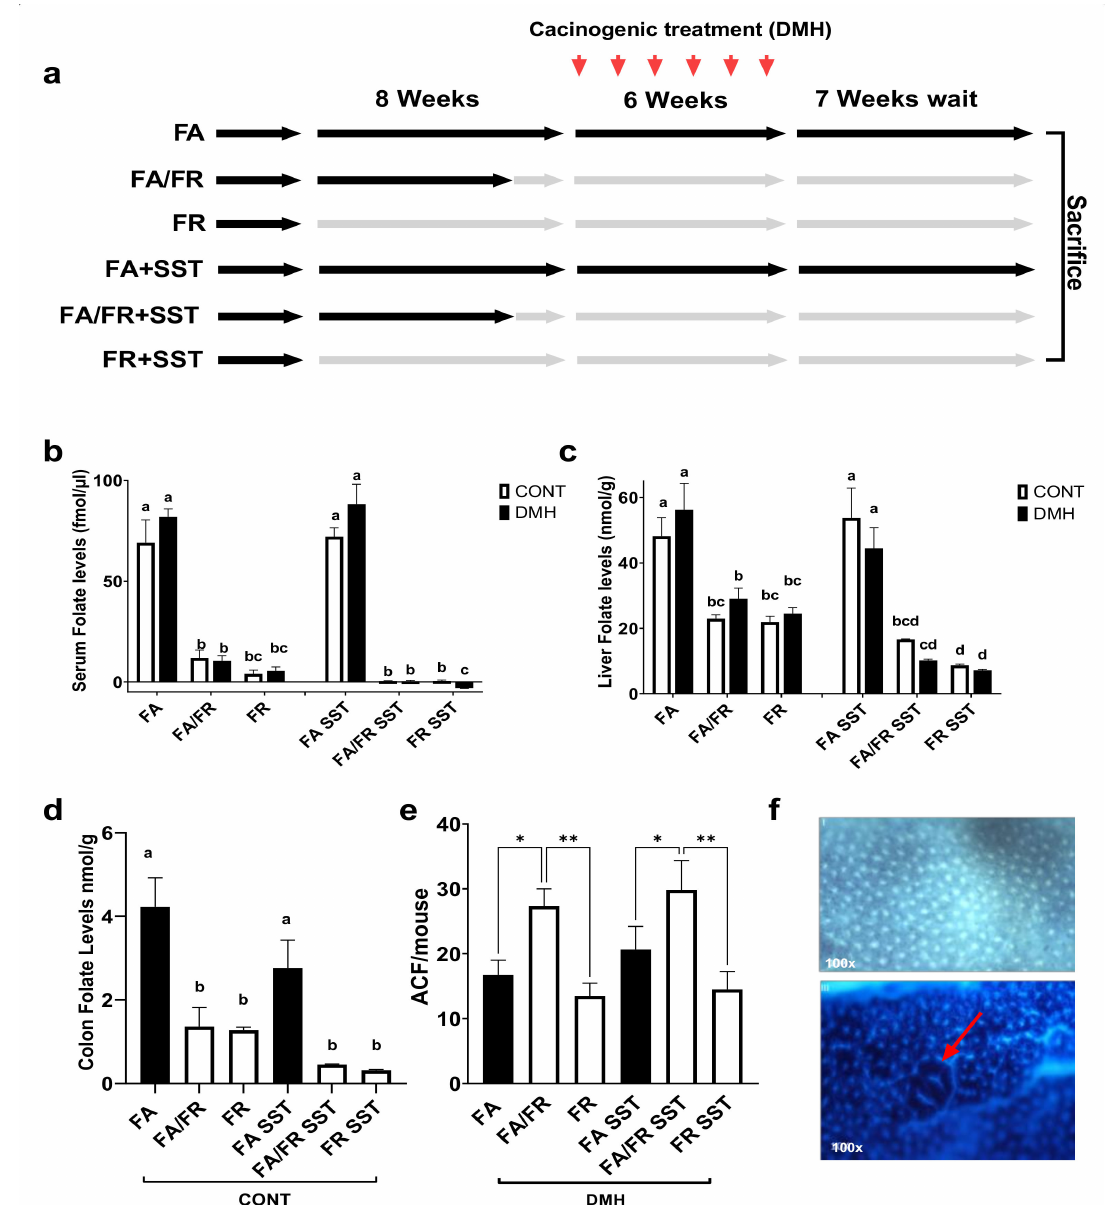
Figure 1. FR reduces ACF formation in DMH-treated male C57BL/6 mice compared to FA/FR, irrespective of SST treatment. ( a ) Study design. ( b ) Effect of FA/FR +/ − SST and FR +/ − SST on serum folate levels. ( c ) Effect of FA/FR +/ − SST and FR +/ − SST on liver folate levels. ( d ) Effect of FA/FR +/ − SST and FR +/ − SST on colon folate levels in untreated controls. ( e ) Effect of FA/FR +/ − SST and FR +/ − SST on colon ACF formation in DMH-treated mice. ( f ) Top image is a stained colon displaying normal crypts, bottom image shows a raised ACF in the center (red arrow). FA = folate adequate diet, FA/FR = folate adequate diet followed by initiation of folate-restricted diet one week prior to DMH injections, FR = folate-restricted diet. SST = 1% succinylsulfathiazole added to diet; CONT= control; no carcinogenic treatment, n = 3; DMH = dimethylhydrazine, a liver/colon tumor initiator, n = 6–7. Bars, S.E.M, means with different letters are significantly different (Tukey’s HSD, p < 0.05), * p < 0.05, ** p <